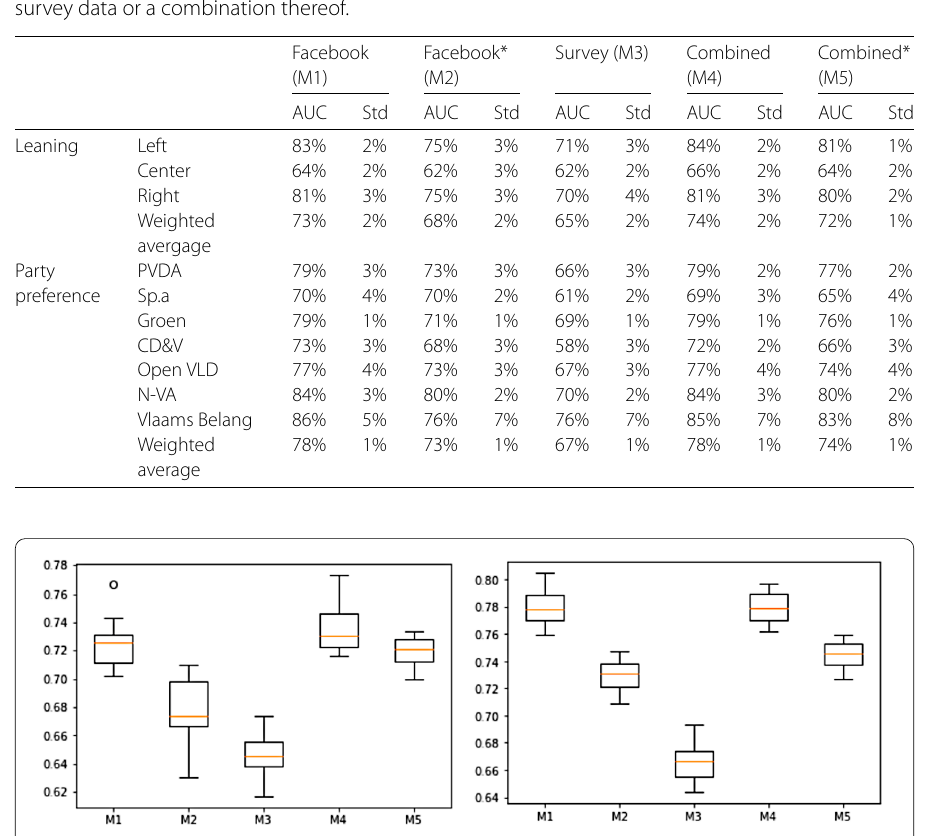
probability density function using a Gaussian kernel 14 to calculate the probability ( p